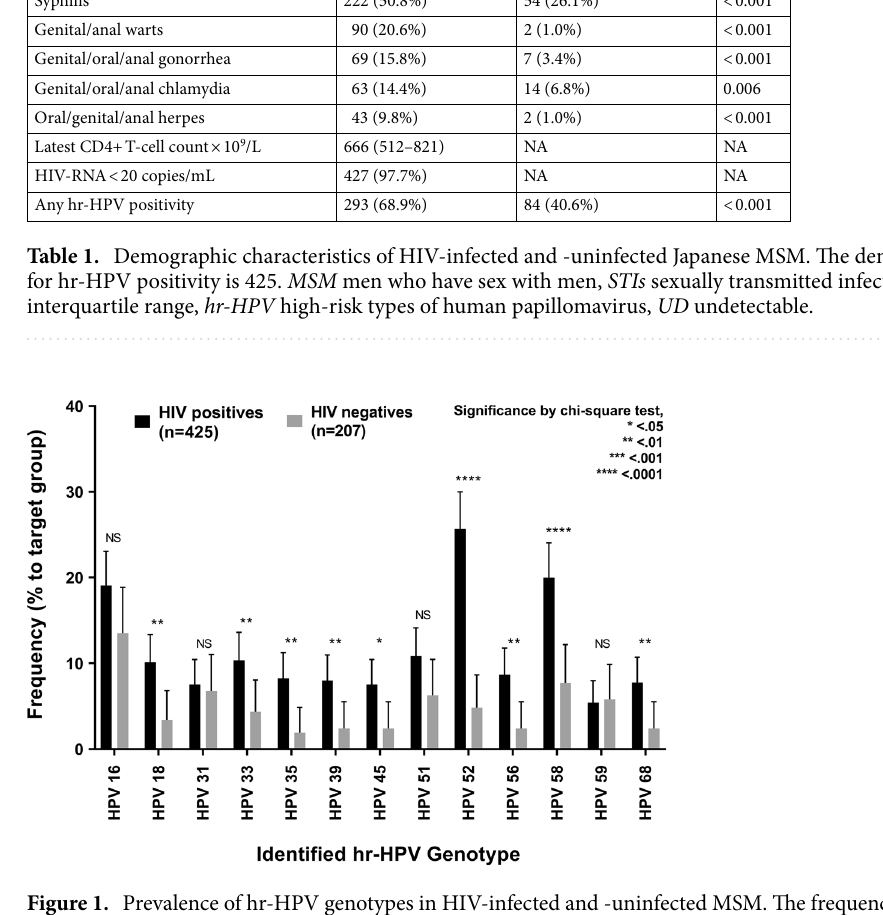
Figure 1. Prevalence of hr-HPV genotypes in HIV-infected and -uninfected MSM. The frequency of each hr-HPV genotype detected between HIV-infected and -uninfected subjects was compared. HPV human papillomavirus, hr-HPV high-risk types of human